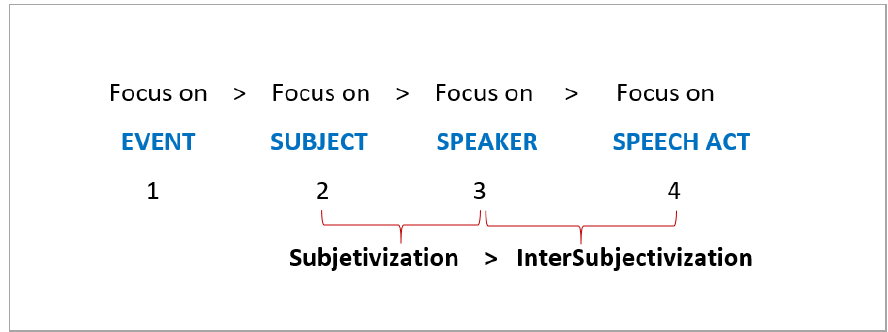
Figure 8 . (Inter)Subjetivization grammaticalization process of the Andean Spanish Evidential Present